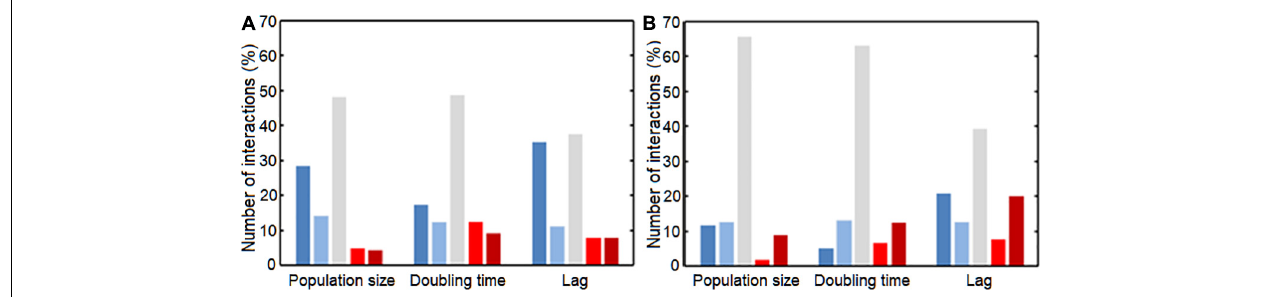
FIGURE 6 | Interactions between commensals and pathogens, classified according to the interaction strength. Interaction strength was subdivided in very negative (Dark blue), slightly negative (Light blue), neutral (Gray), slightly positive (Light red), and very positive (Dark red). Groups were divided based on ε -value; very negative: ε < log(0.6) = –0.51, slightly negative: log(0.6) = –0.51 < ε < log(0.8) = –0.22, neutral: log(0.8) = –0.22 < ε < log(1.2) = 0.18, slightly positive: log(1.2) = 0.18 < ε < log(1.4) = 0.33, and very positive: ε > log(1.4) = 0.33 interactions. (A) Commensal acceptors were exposed to conditioned medium of uropathogen donors. (B) Uropathogen acceptors were exposed to conditioned medium of commensal donors. For the very negatively affected interactions, there was a significant difference for the affected population size, doubling time and lag phase between the commensals and uropathogens ( p = 0.0036, p = 0.0042, p = 0.0144, respectively). Uropathogens showed a significant shortening of the lag phase compared to commensals ( p = 0.0072). Significance of interaction comparisons was tested using a t- test with Bonferroni correction for multiple comparisons ( p <